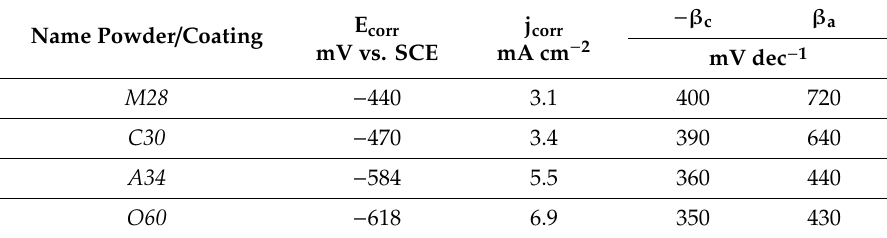
Table 2. Corrosion electrochemical parameters of nickel coatings on Al7075